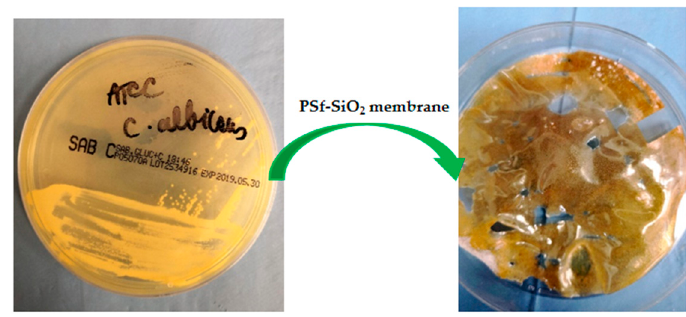
Figure 11. Candida albicans proliferation for the tested PSf-SiO 2 membrane.